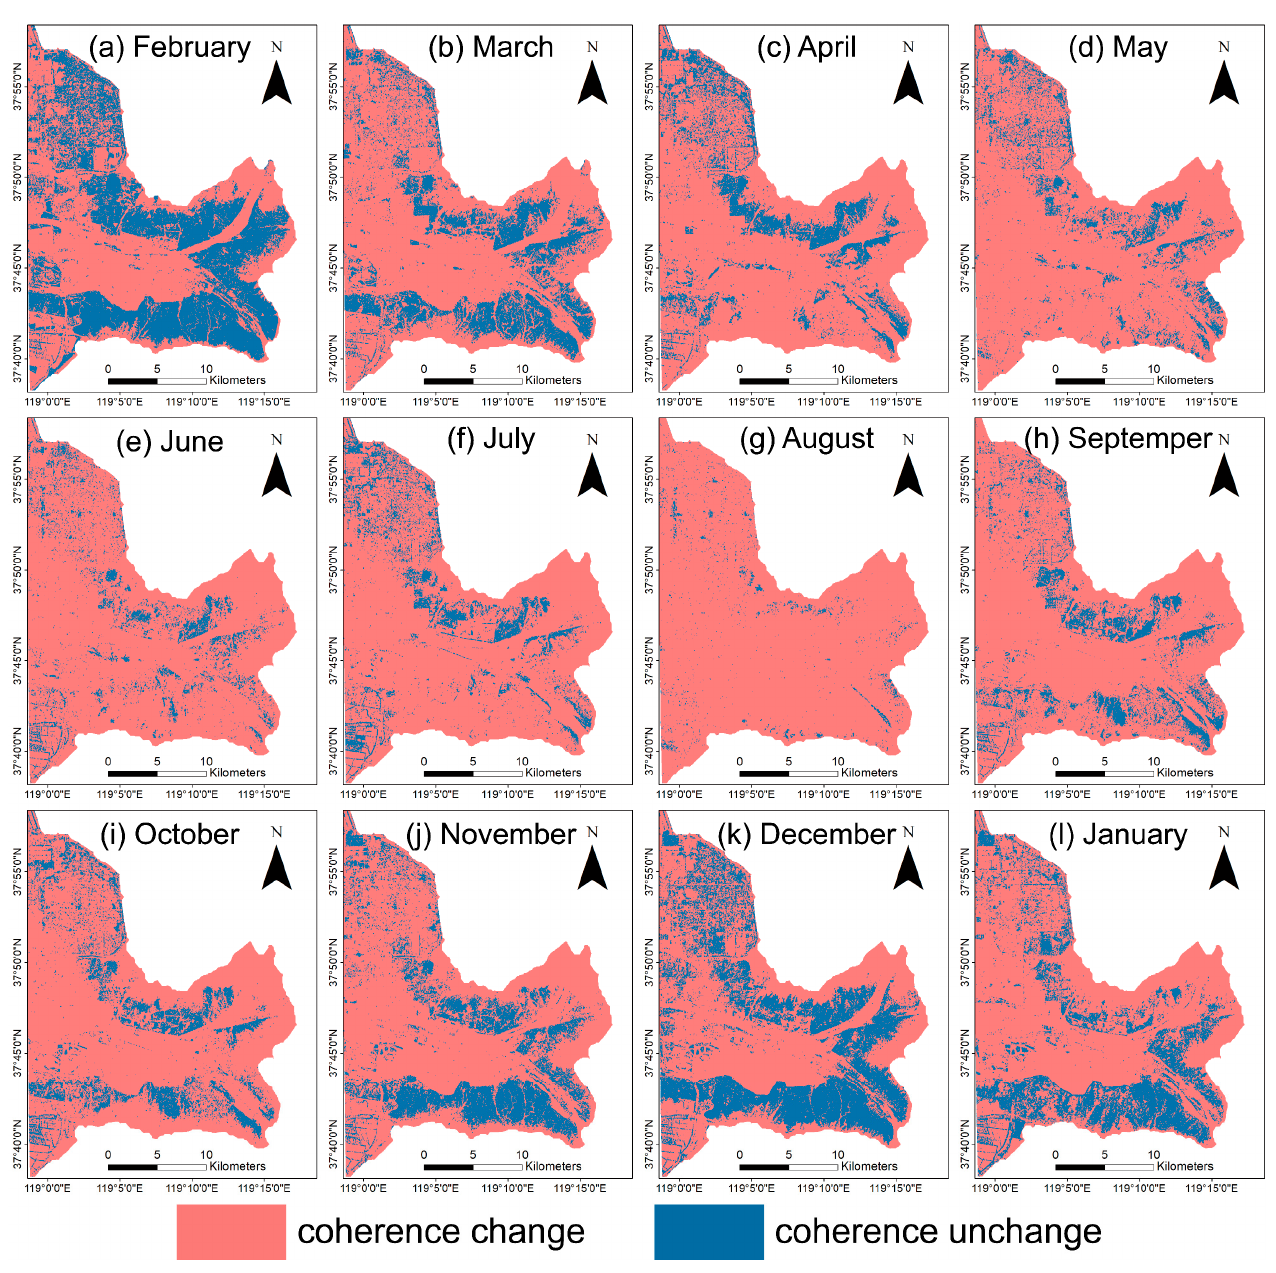
Figure 12. Seasonal coherence change over the YRD in 2019 with the OTSU algorithm. Spring lasts from March to May ( b – d ), Summer lasts from Jun to August ( e – g ), Autumn lasts from September to November ( h – j ), and Winter lasts from December to February next year ( k , l , a ).